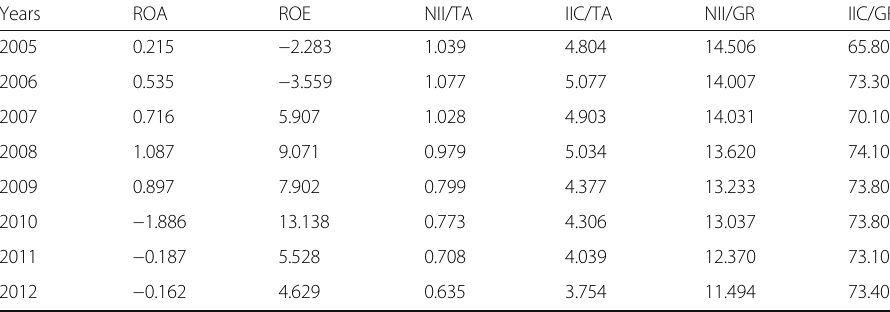
Table 2 Evolution of the average ROA, ROE, NII and IIC (Value are in %) Years ROA ROE NII/TA IIC/TA NII/GR IIC/GR 2005